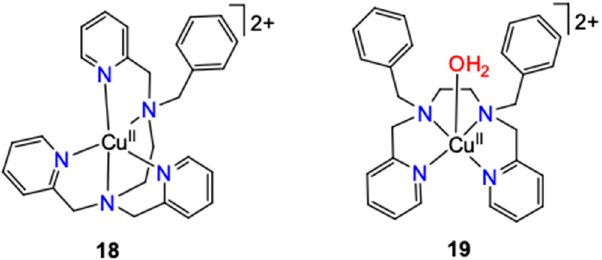
Figure 10. Structural view of catalysts containing amine and pyridine donor groups [59].